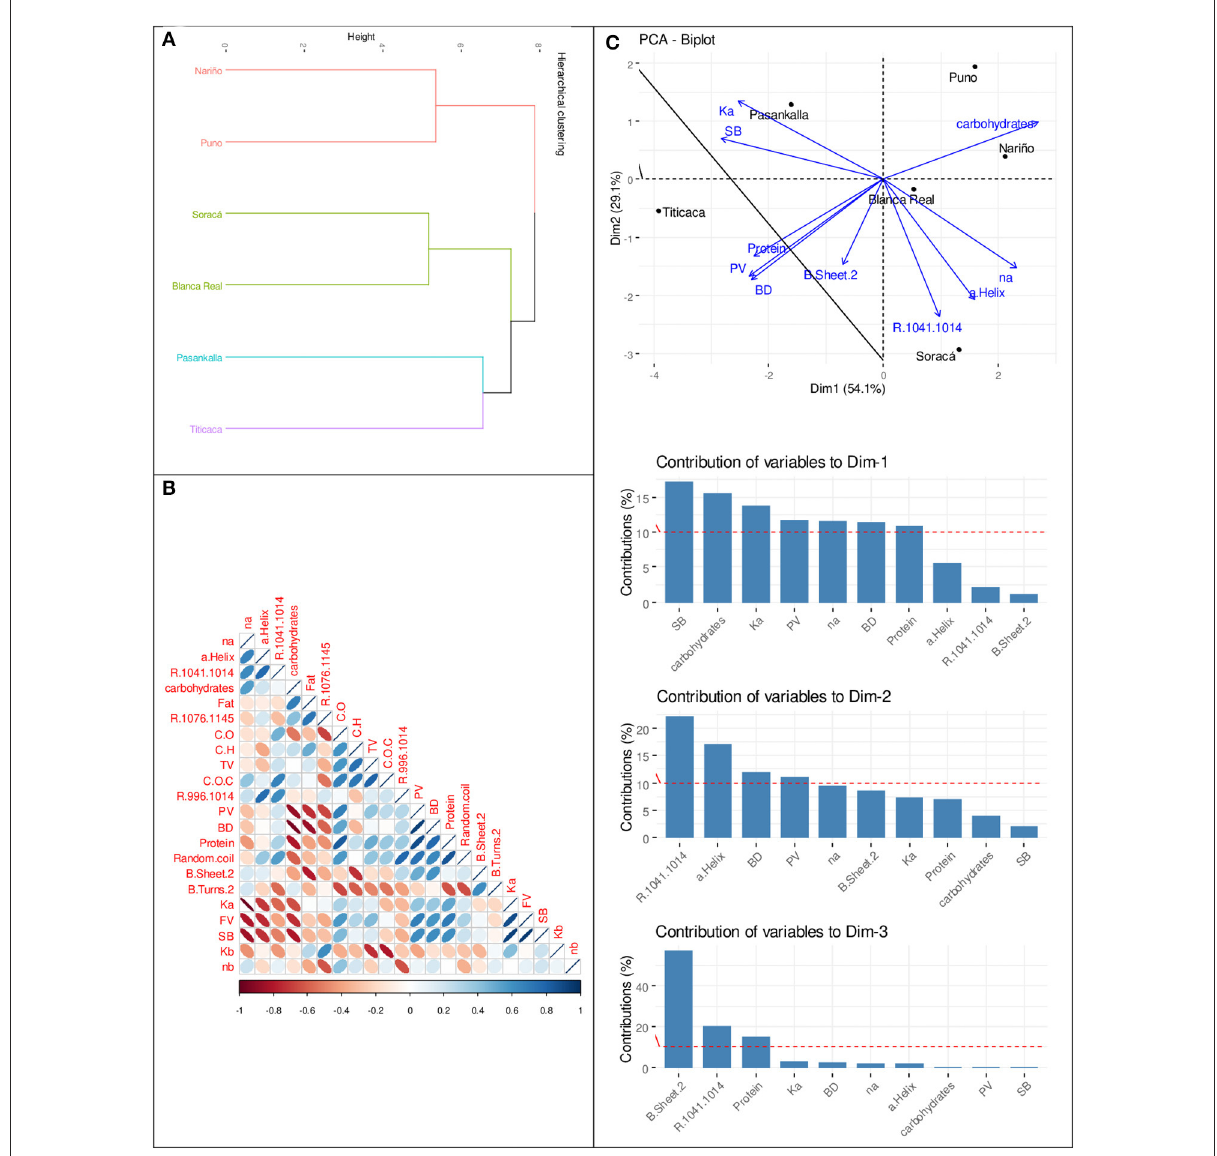
FIGURE5 Hierarchical cluster analysis of the evaluated quinoa functional properties (A) . Spearman correlation analysis between physicochemical, rheological and structural variables (B) . Principal components analysis PCA of the physicochemical, rheological and structural variables (C) . In (B) , C.O is C = O; C.H is C-H; C.O.C is C-O-C; R.996.1012 is 996/1,014 cm − 1 ratio; R.1076.1145 is 1,076/1,145 cm − 1 ratio; PV is Peak viscosity; TV is Trough viscosity; BD is Breakdown viscosity; SB is Setback viscosity; Ka and na are Consistency index and flow index after heating, respectively; Kb and nb are consistency index and Flow index before heating